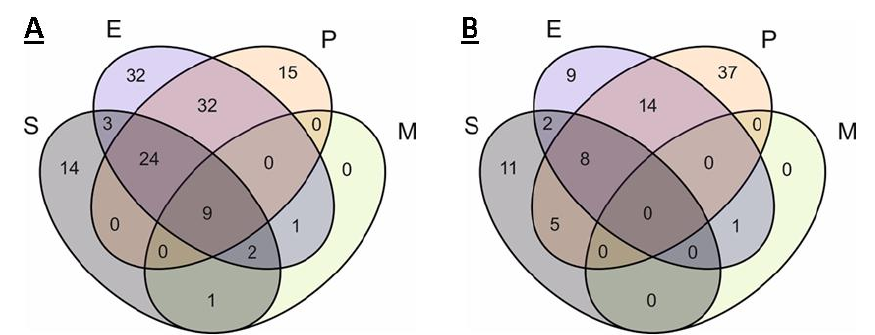
Figure 6. Venn diagram of the occurrence of different KEGG modules in the pangenome ( A ) and core genome ( B ) in organisms. S, E, P, and M indicate ellipses corresponding to S. aureus , Enterobacter spp., P. aeruginosa , and Mycoplasma spp.